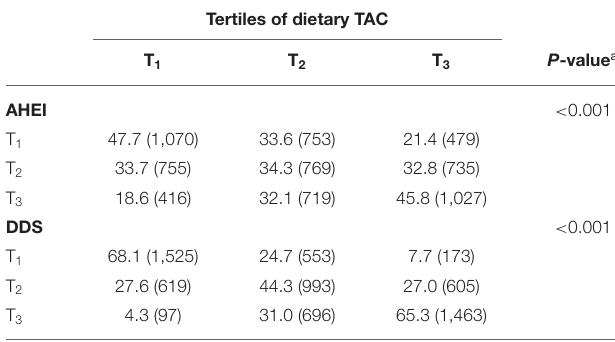
TABLE 3 | Participants’ distribution across tertiles of dietary TAC, AHEI, and DDS. Tertiles of dietary